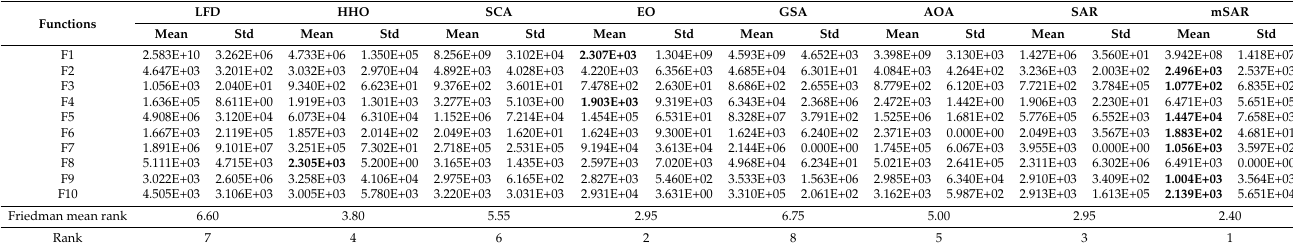
Table 2. STD and mean of the optimum value obtained from the proposed mSAR algorithm against other competing algorithms on the CEC’2020 benchmark functions with D =